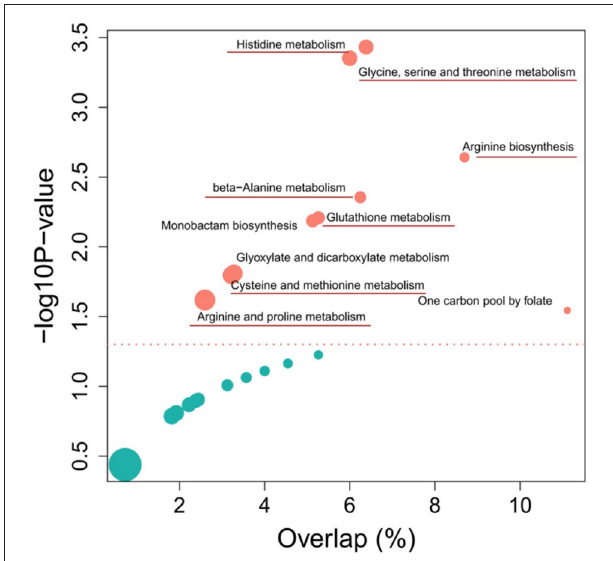
FIGURE 4 | Top 10 enriched metabolic pathways of the comparison between Sumai 3 and Shannong 20 after F. graminearum infection. The y-axis and x-axis respectively represent the significance and importance value of the metabolic pathway, bubble size represents the differential metabolites (DFMs) proportion in the metabolic pathway. Detailed information on metabolic pathways in Supplementary Table 3